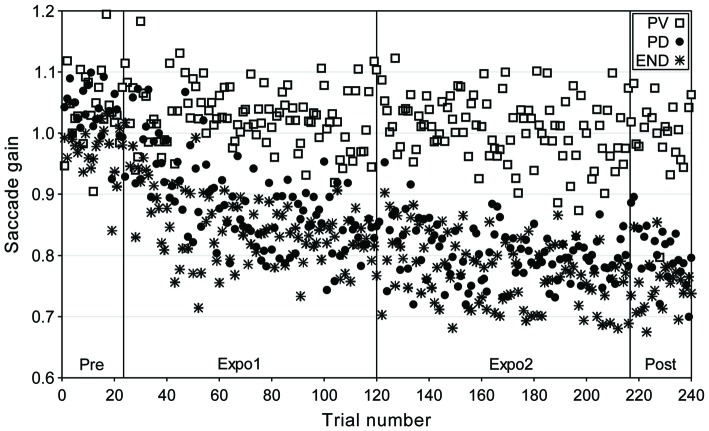
Time-course of gain changes for a representative subject (BL) in the “PV”, “PD” and “END” conditions of experiment I (adaptive saccade shortening). Saccadic gain is plotted as a function of trial number for the different experimental phases: Pre (trials 1–24); exposure 1 (Expo1: trials 25–120); exposure 2 (Expo2: trials 121–216) and Post (trials 217–240). Different symbols represent the gain of saccades in the “PV” (open squares), “PD” (filled circles) and “END” (star) conditions.